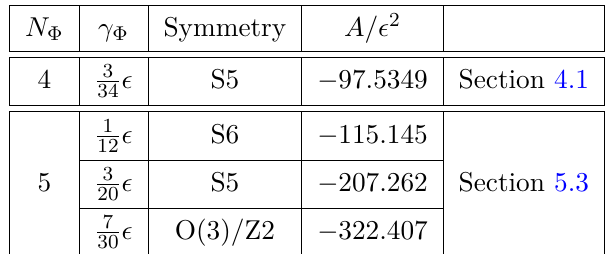
Table 1 . All perturbatively unitary N =1 fixed points with three or less interacting scalar super- fields.